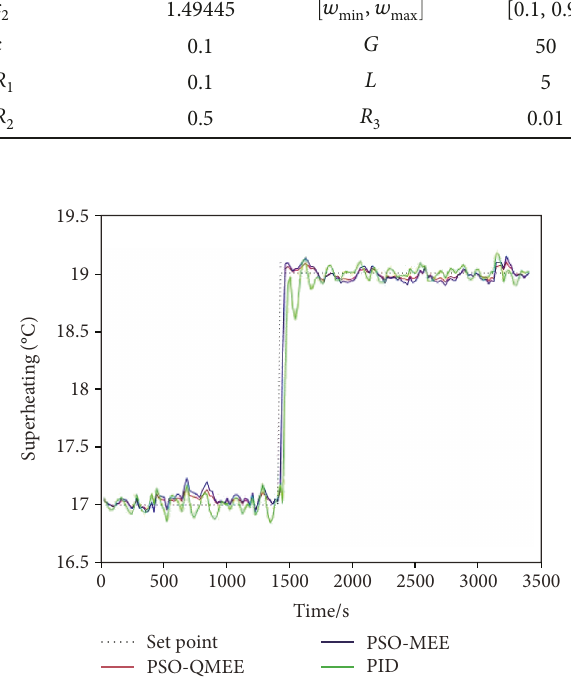
Figure 4: Response curves of superheating.